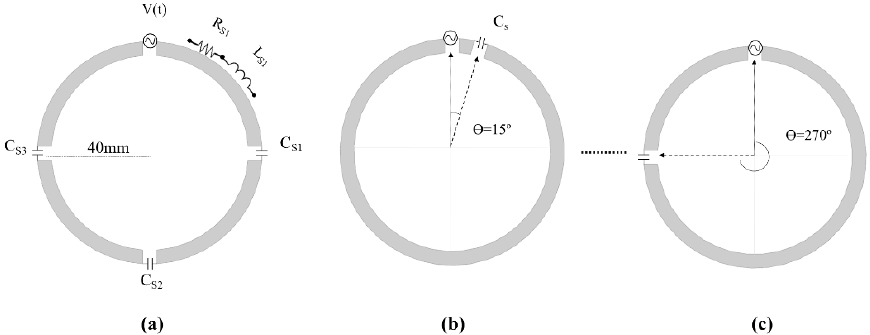
Figure 1. Visualization of concept of non-symmetric distributed RF coils, with ( a ) reference, and coils with capacitor positions at ( b ) 15° and ( c ) 270°. Models for EM simulations involving.